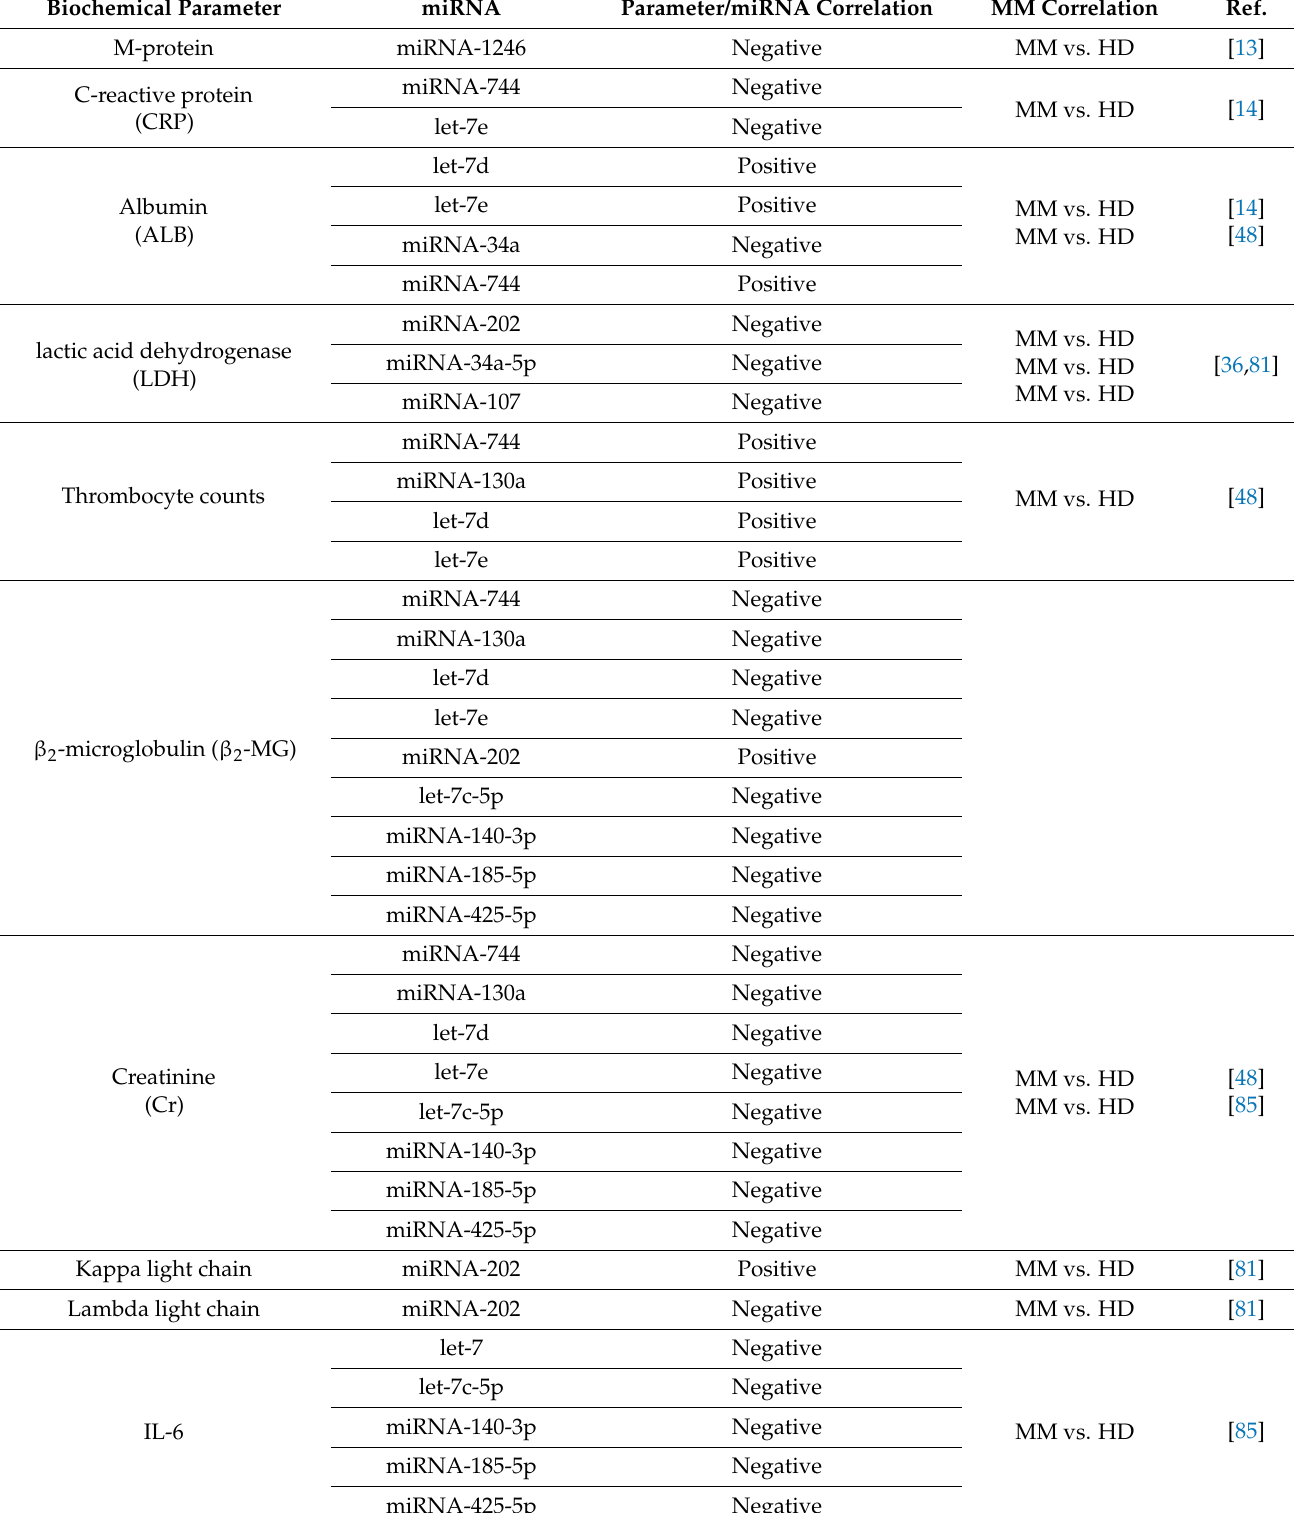
Table 2. Correlation between MM biochemical parameters and circulating